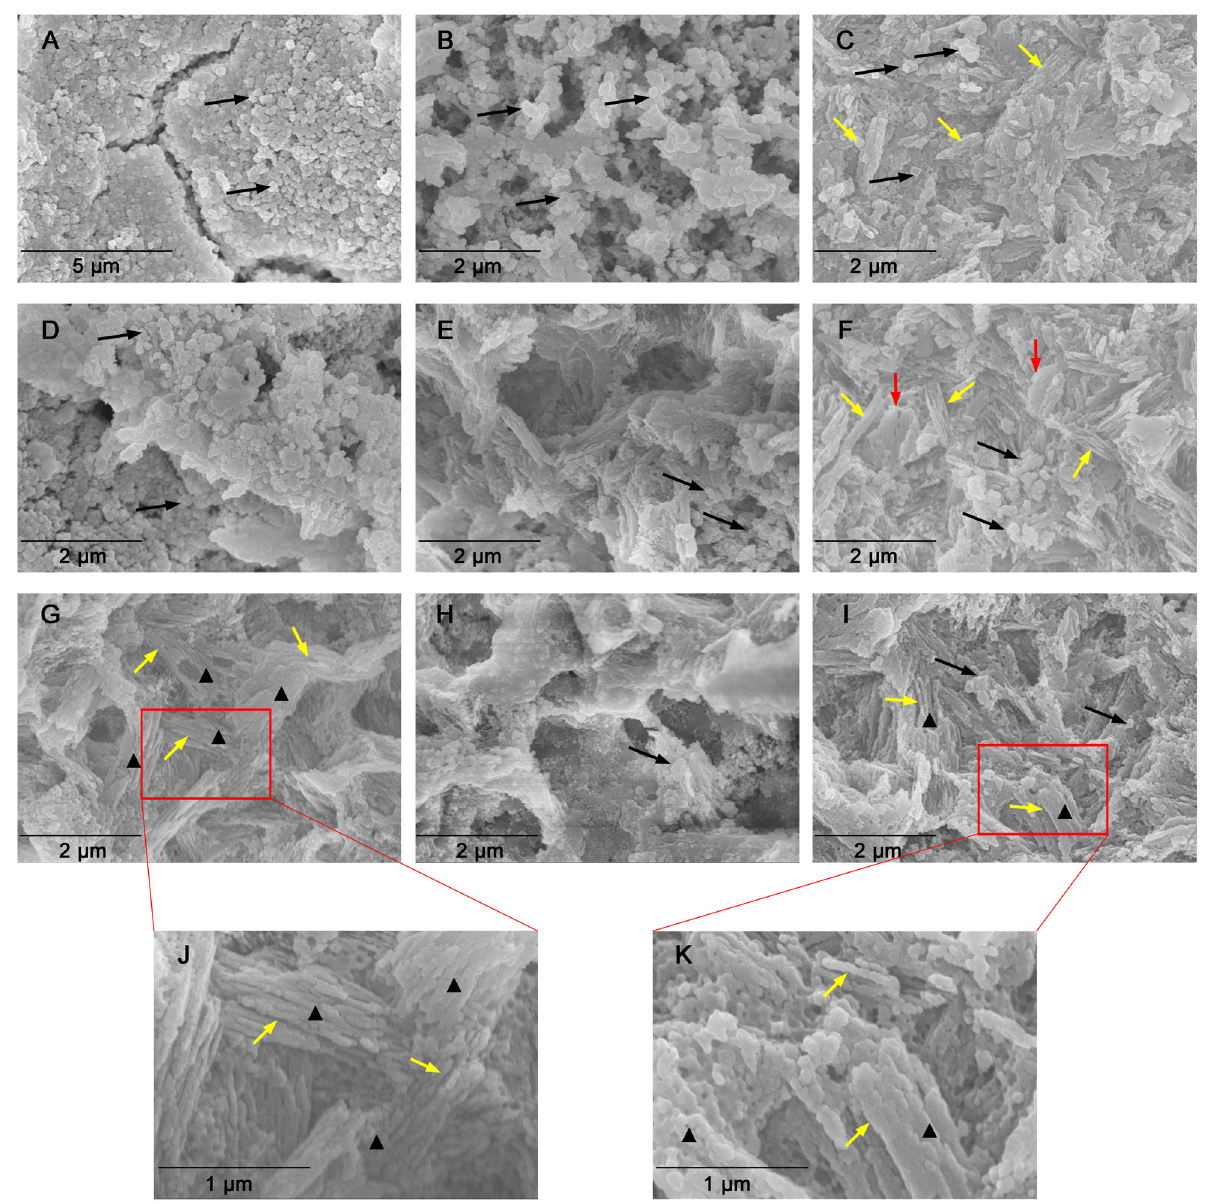
Fig. 6 SEM images of representative morphologies of LDGC materials heated under various thermal conditions. A